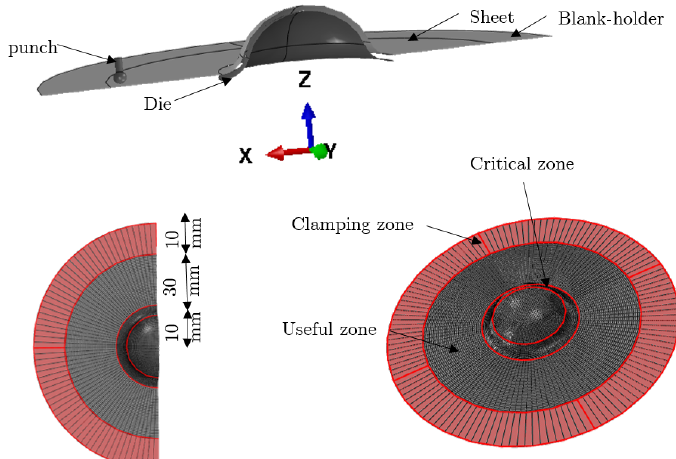
Figure 10. 3D CAD model, FE meshing, and partition of initial